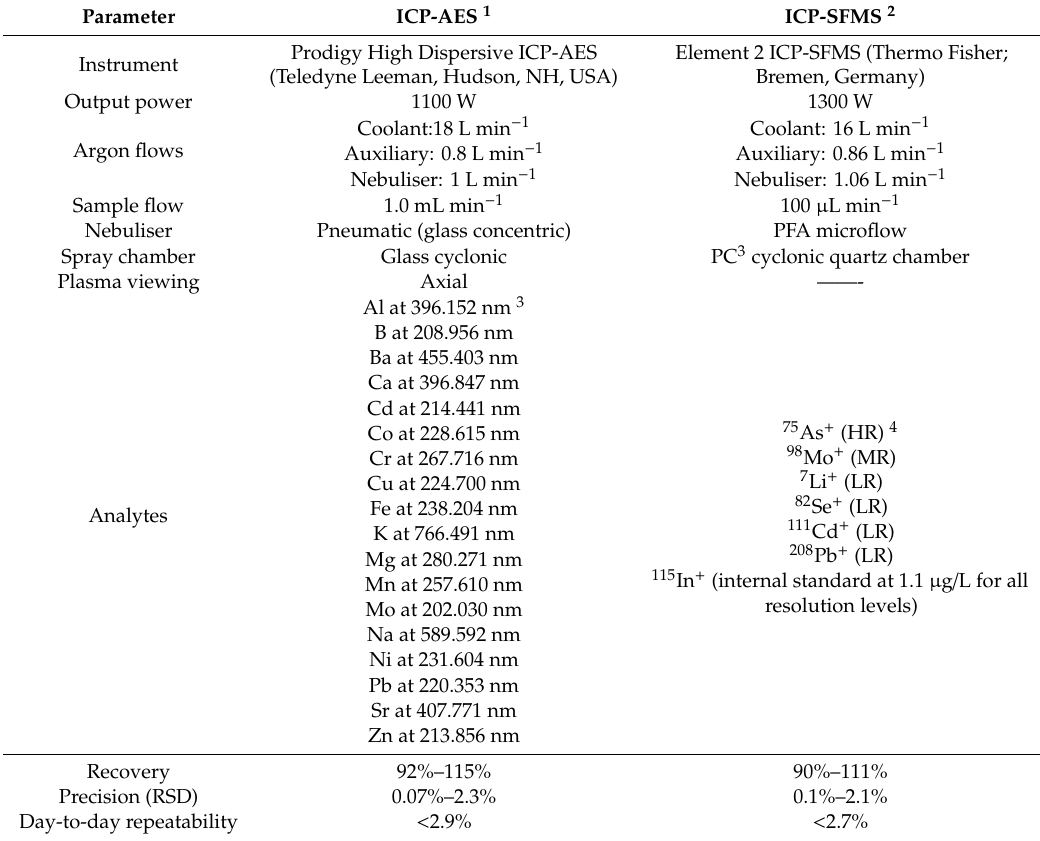
Table 1. Instrumental conditions and figures of merit for both analytical methods